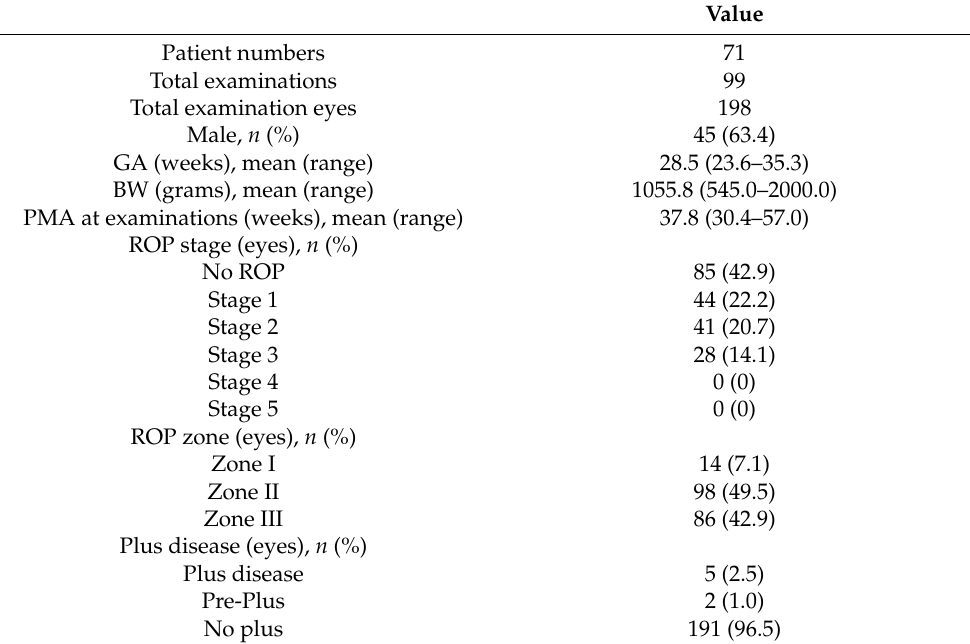
Table 1. Demographic data of the study population.